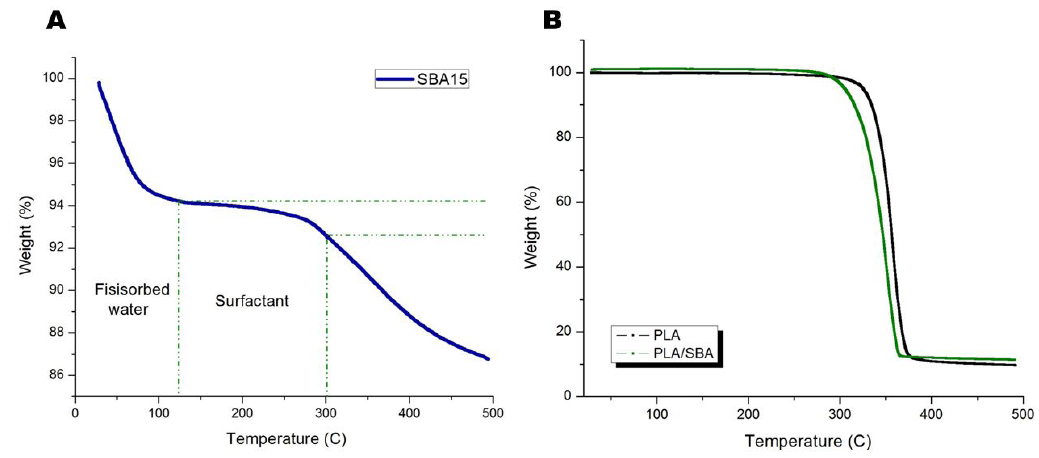
Figure 7. TGA of SBA‑15 mesoporous ceramic material (A) and TGA of the PLA fiber spun mat of 10%, and PLA/SBA‑15 fiber composite (B).